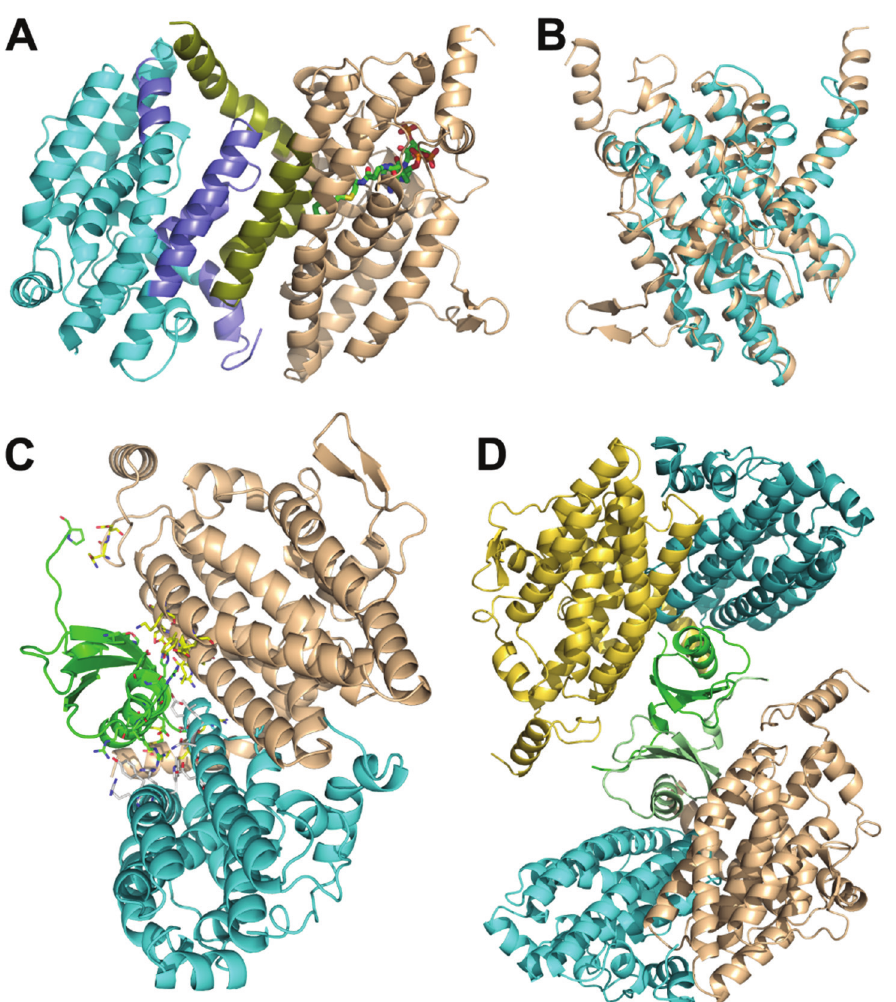
Figure 2. Paa monooxygenase complex. ( A ) The PaaA-PaaC heterodimer with bound phenylacetyl-CoA. The catalytic PaaA subunit is painted in a wheat color, the structural PaaC subunit is painted in cyan. ( B ) Superposition of PaaA (wheat) and PaaC (cyan); ( C ) The PaaACB heterotrimer. PaaA is painted wheat, PaaC is cyan and PaaB is green. The residues at the interface of PaaB with PaaA and PaaC are shown in stick mode. ( D ) The (PaaACB) 2 heterohexamer. PaaA is painted wheat and olive, PaaC is cyan and light blue, and PaaB is green and light